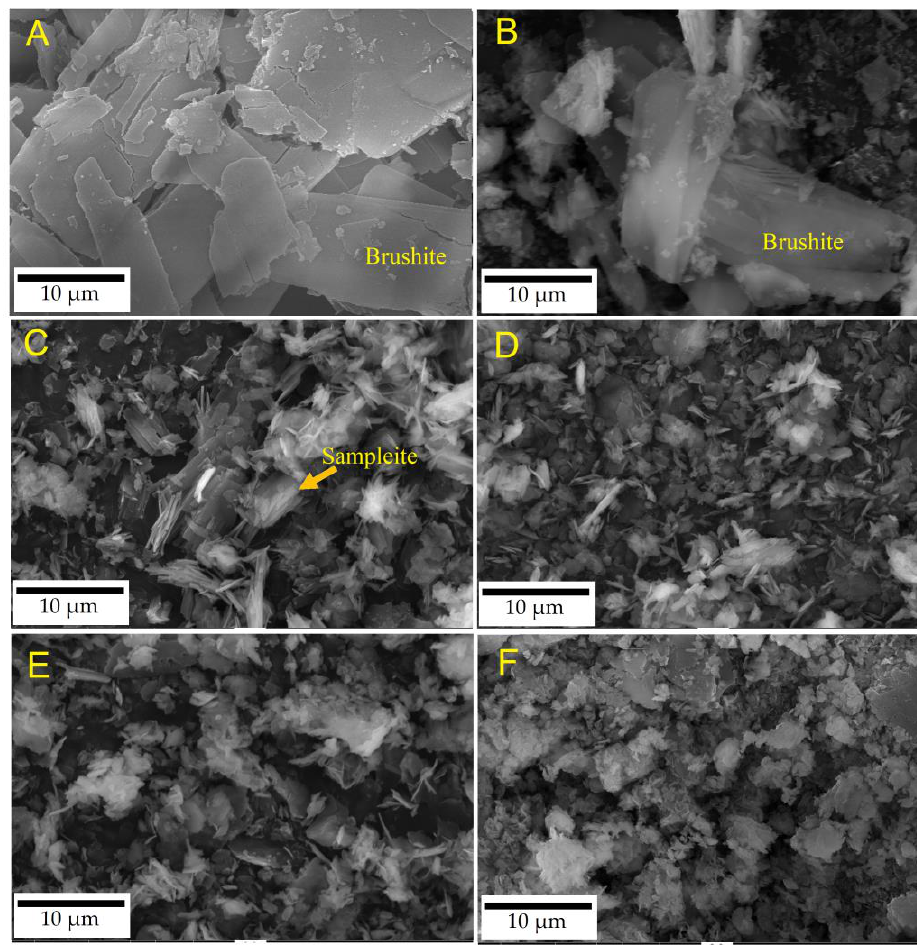
Figure 4. SEM images of Ca-Cu phosphates, ( A ) BCu0, ( B ) BCu1, ( C ) BCu4, ( D ) BCu5, ( E ) BCu6, and ( F ) BCu10 (all images have the same 10 µm scale bar) . ( F ) BCu10 (all images have the same 10 µ m scale